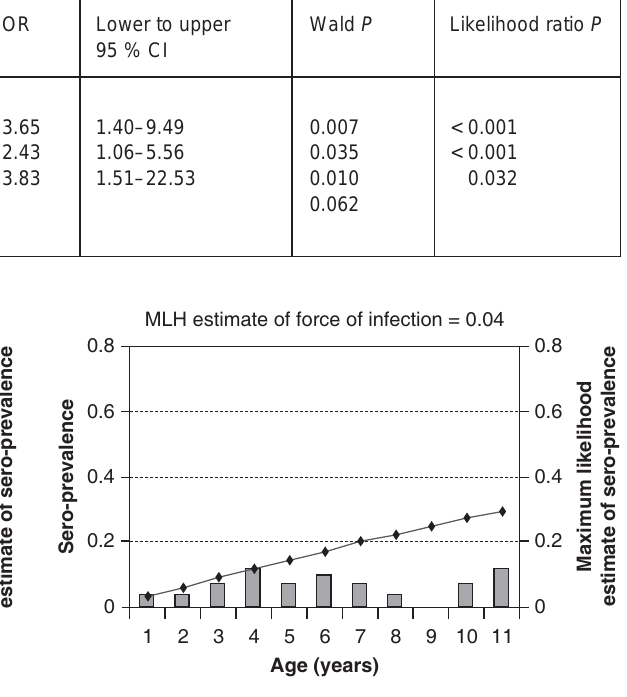
FIG. 1 Force of infection estimates for Babesia bovis infection in dairy cattle—Iringa, Tanzania (January to April 1999)